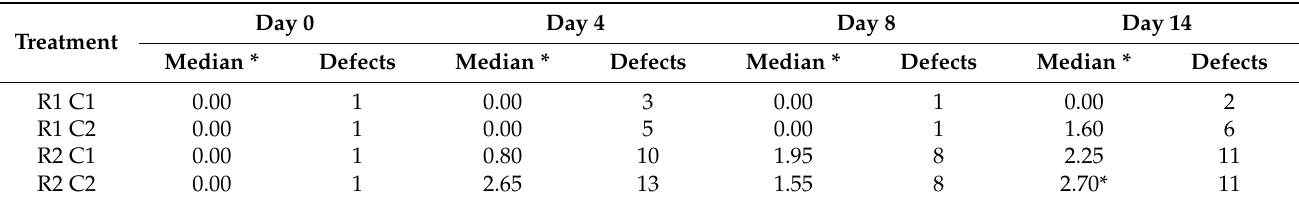
Table 3. Number of defects and the median of their intensity as reported by the sensory panel, in the oil extracted from the ‘Arbequina’ cultivar, harvested with a Manual Inverted Umbrella (R1) or in a traditional way (R2) and stored for 0, 4, 8, and 14 days at 5 ◦ C (C1) or at ambient temperature (C2). The panel was formed by 8 approved tasters. Treatment